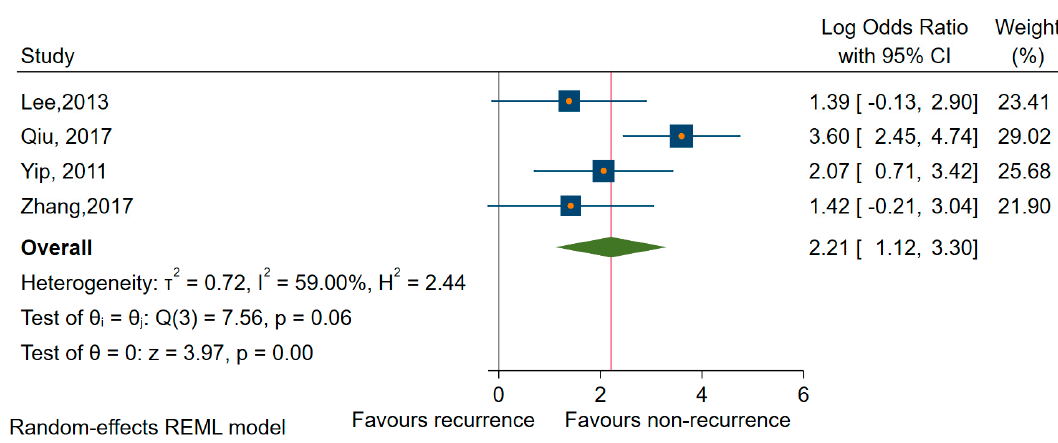
Figure 10. Forrest plot of the association between miR-146b expression and recurrence.